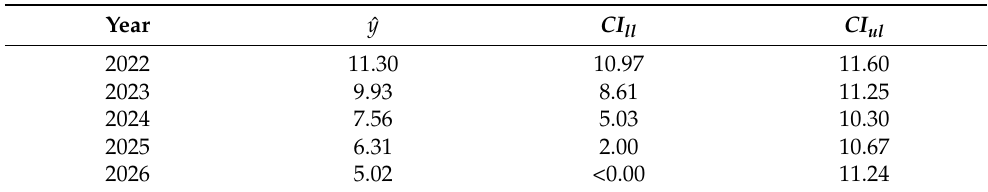
Table 6. Projection of population coverage for publicly funded cervical cancer screening as part of a prevention program in Poland.